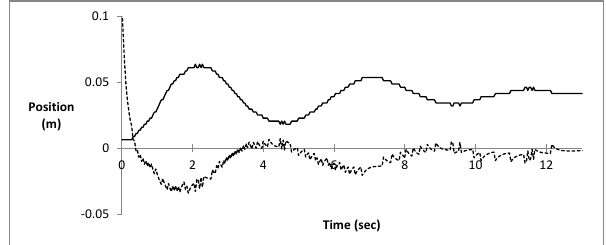
Figure 26: Step response of linear P‐D controller using filtered derivative Figure 25. Simulated discrete step response of linear PD controller using fil- tered derivative.